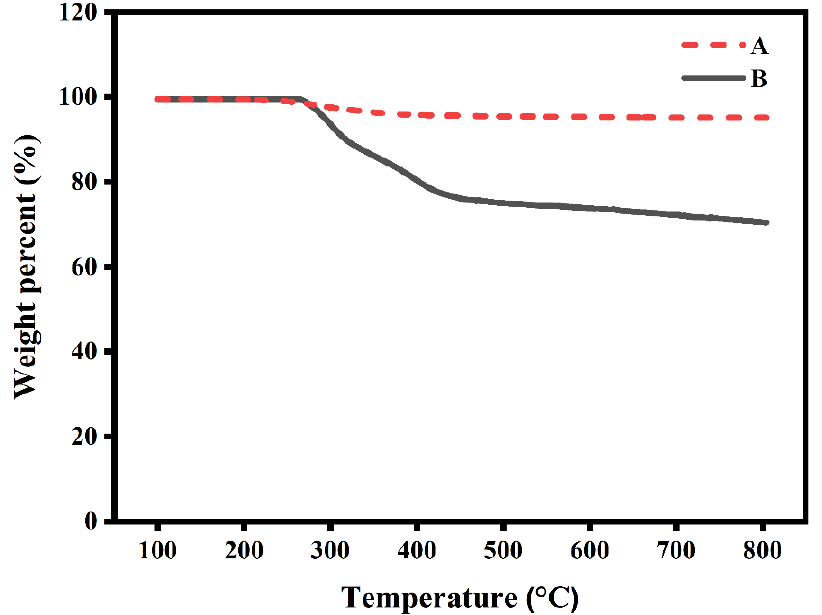
Figure 2. TGA curves of the pure magnetic matrix (A) and magnetic matrix embedded 50 nm NHG’s (B).